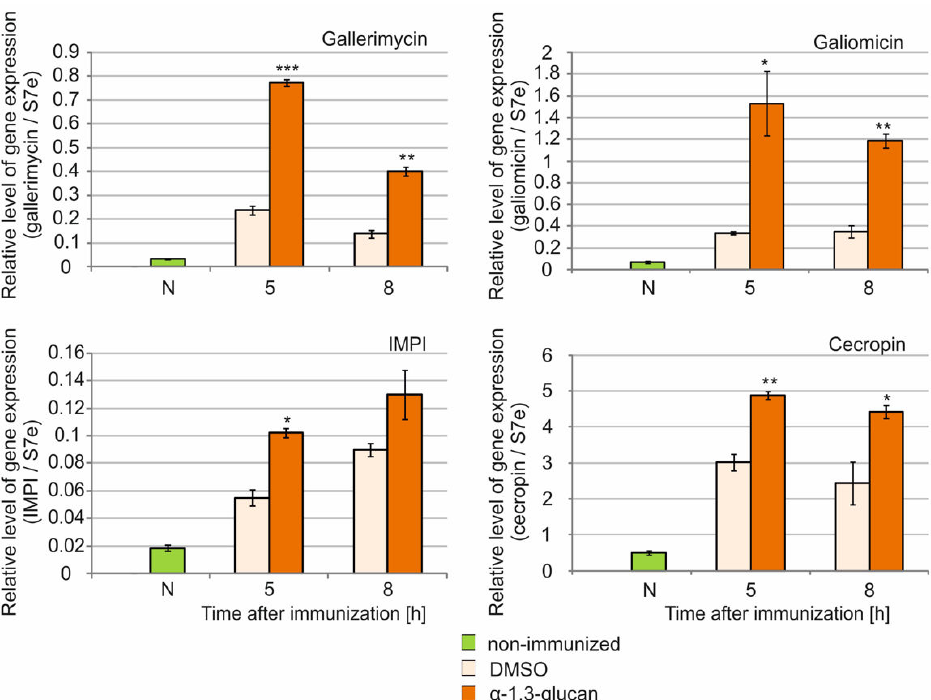
Figure 6. Expression of genes of selected defense peptides in the fat body of G. mellonella larvae after immunization with A. niger α -1,3-glucan. The level of expression of gallerimycin, galiomicin, IMPI, and cecropin genes was tested in the fat body of non-immunized larvae (N) and 5 h and 8 h after immunization with α -1,3-glucan (5 µ g) and DMSO (control) using real time qPCR as described in the Materials and Methods. Statistically significant differences between the mean values (from three independent experiments) obtained at the respective times after immunization with α -1,3-glucan and DMSO are marked with asterisks: * p < 0.05, ** p ≤ 0.01, *** p ≤